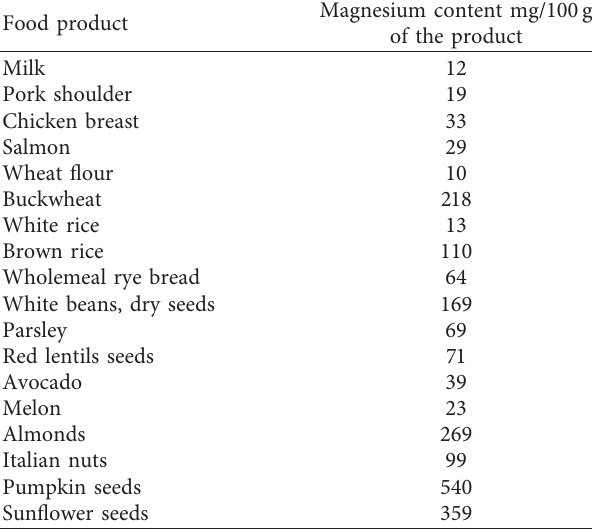
Table 6: Magnesium content of selected food products [39]. Food